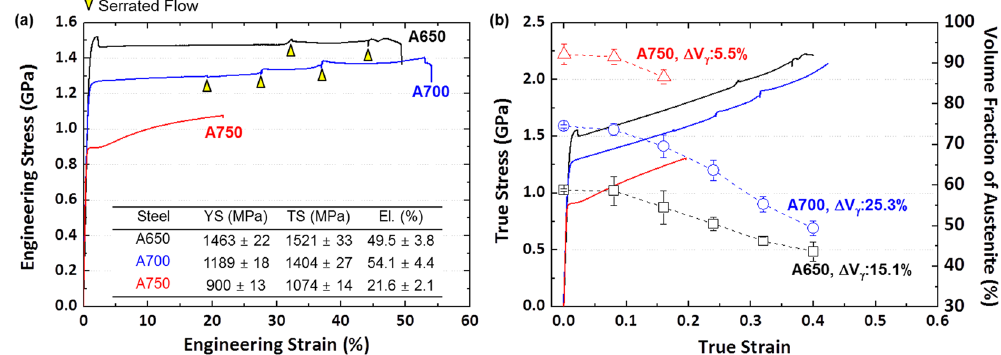
Figure 3. Room-temperature tensile properties and austenite volume fractions. ( a ) Room-temperature tensile engineering stress-strain curves and tensile properties. The A650 steel shows extremely high yield and tensile strengths (1.46 and 1.52 GPa, respectively) and high elongation of 50%. ( b ) True stress-strain curves (solid lines) and austenite volume fractions (dashed lines). The true tensile strengths of the A650 and A700 steels continuously increase to 2.1 GPa with increasing true